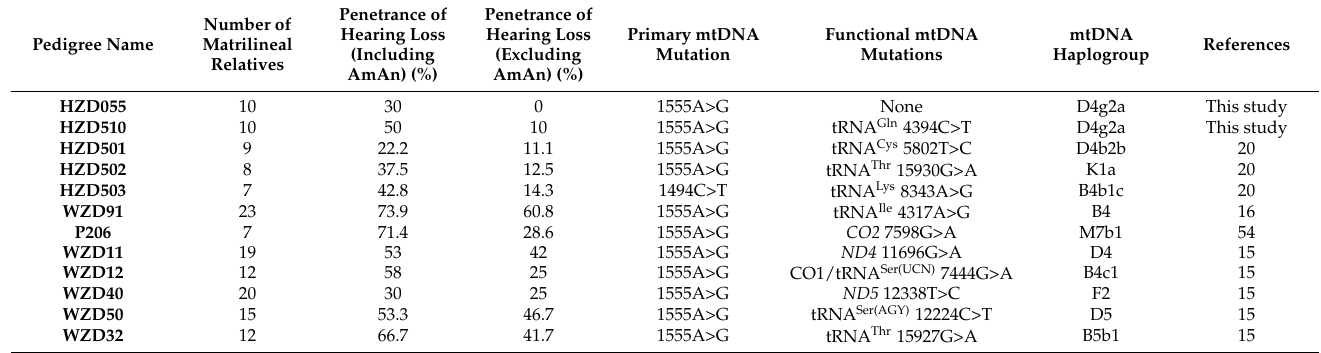
Table 5. Summary of clinical and molecular data for 12 families with hearing